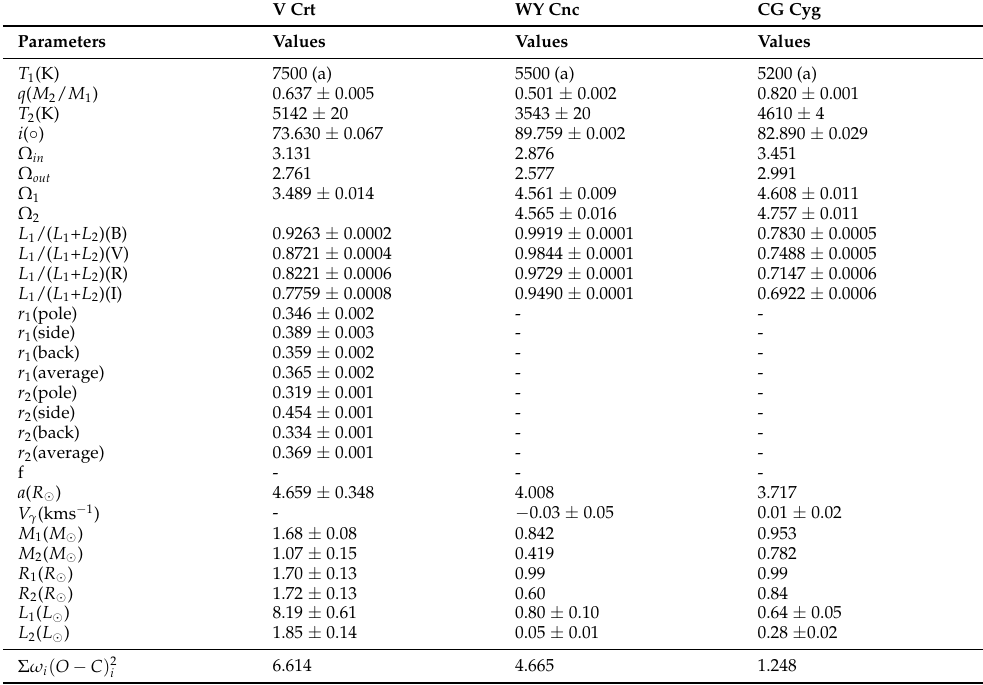
Table 5. Orbital Parameters of V Crt, WY Cnc and CG Cyg.